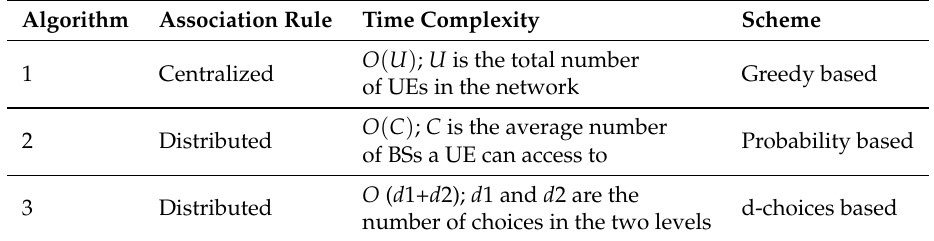
Table 4. Comparison of different